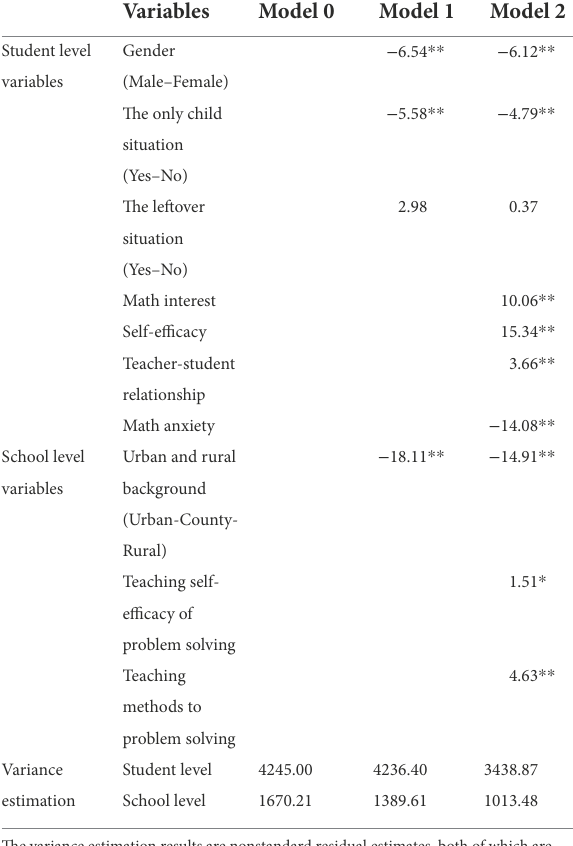
TABLE 3 Students’ mathematical problem-solving performance and influencing factors HLM analysis